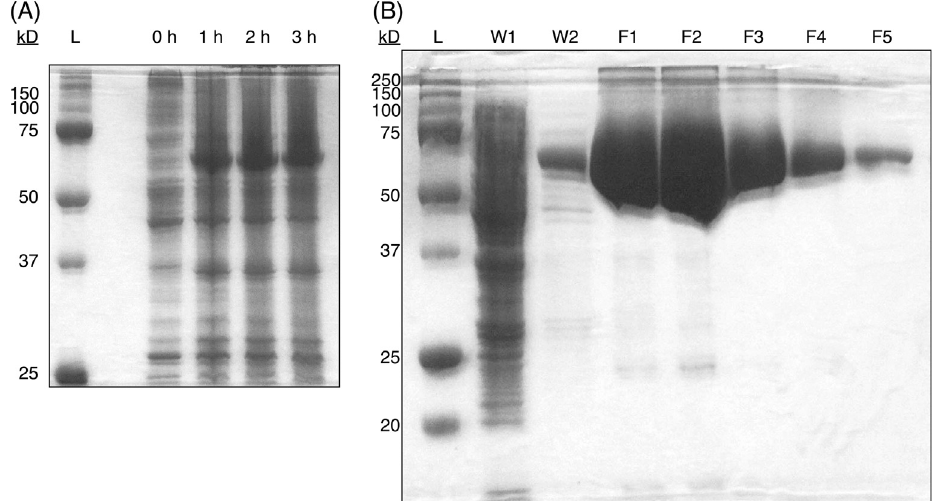
Figure 5. (A) SDS-PAGE analysis of E. coli whole cell lysates before and after the induction of CTPS expression. Lane L, protein size- standard ladder with the molecular weight (kD) labeled next to each corresponding band. (B) SDS-PAGE analysis of fractions collected during the puri fi cation of the CTPS enzyme by af fi nity chromatography. Wash fractions are labeled W1 and W2; elution fractions are labeled as F1, F2, F3, F4, and F5.